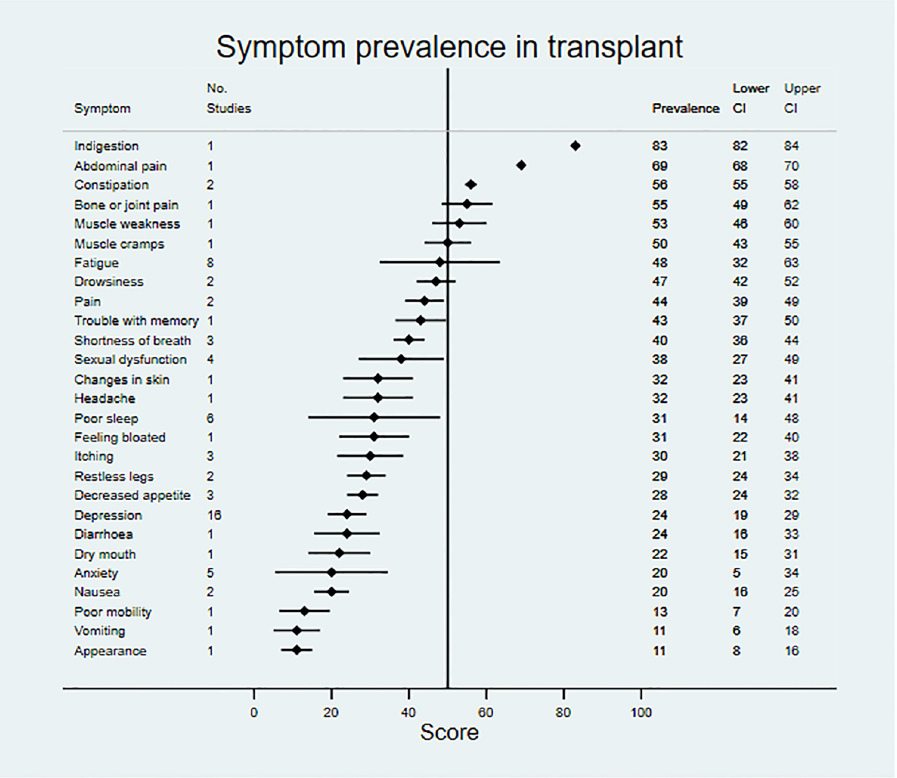
Fig 4. Pooled prevalence of patient-reported symptoms across included studies for patients in receipt of a kidney transplant.